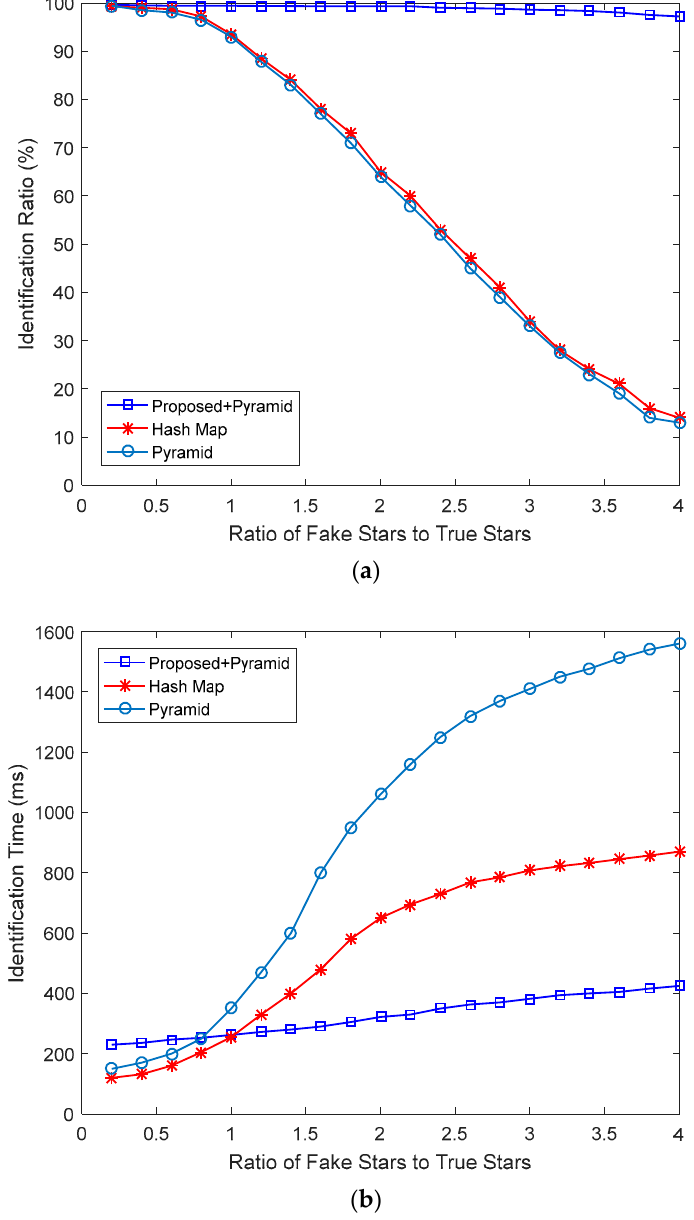
Figure 8. ( a ) Identification ratio; ( b ) Identification time.